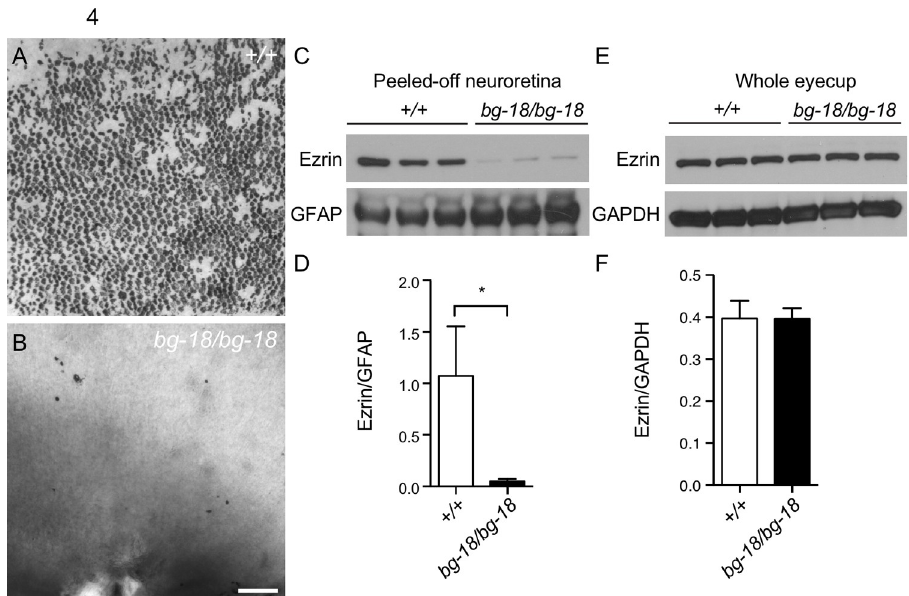
Fig 4. Reduced retinal adhesion in Lyst mutant mice. (A-B) Pigment remaining on peeled-off retina from 7-week- old wild type (A) and mutant (B) eyes. Scale bar = 100 μ m. C-D. Reduced ezrin level in the mutant neuroretina shown by western blot analysis (C). Quantified results are shown (D). Ezrin levels were normalized to the levels of GFAP. (E-F) Total ezrin levels are similar in mutant and wild type control eyecups in western blot analysis (E) and quantified results (F). � : P < 0.05, mean ± SD, n = 3 per